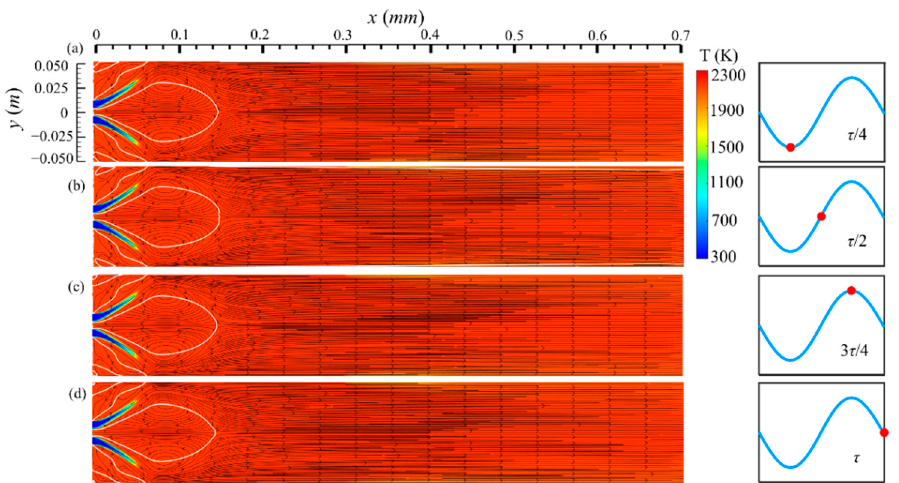
Figure 14. Temperature contour along with zero axial velocity isolines and streamlines and over a period. ( a ) τ /4 ( b ) τ /2 ( c ) 3 τ /4 and ( d ) τ at T H = 500 K, where S N = 0.45, V a = 180 L/min and T i = 300 K.